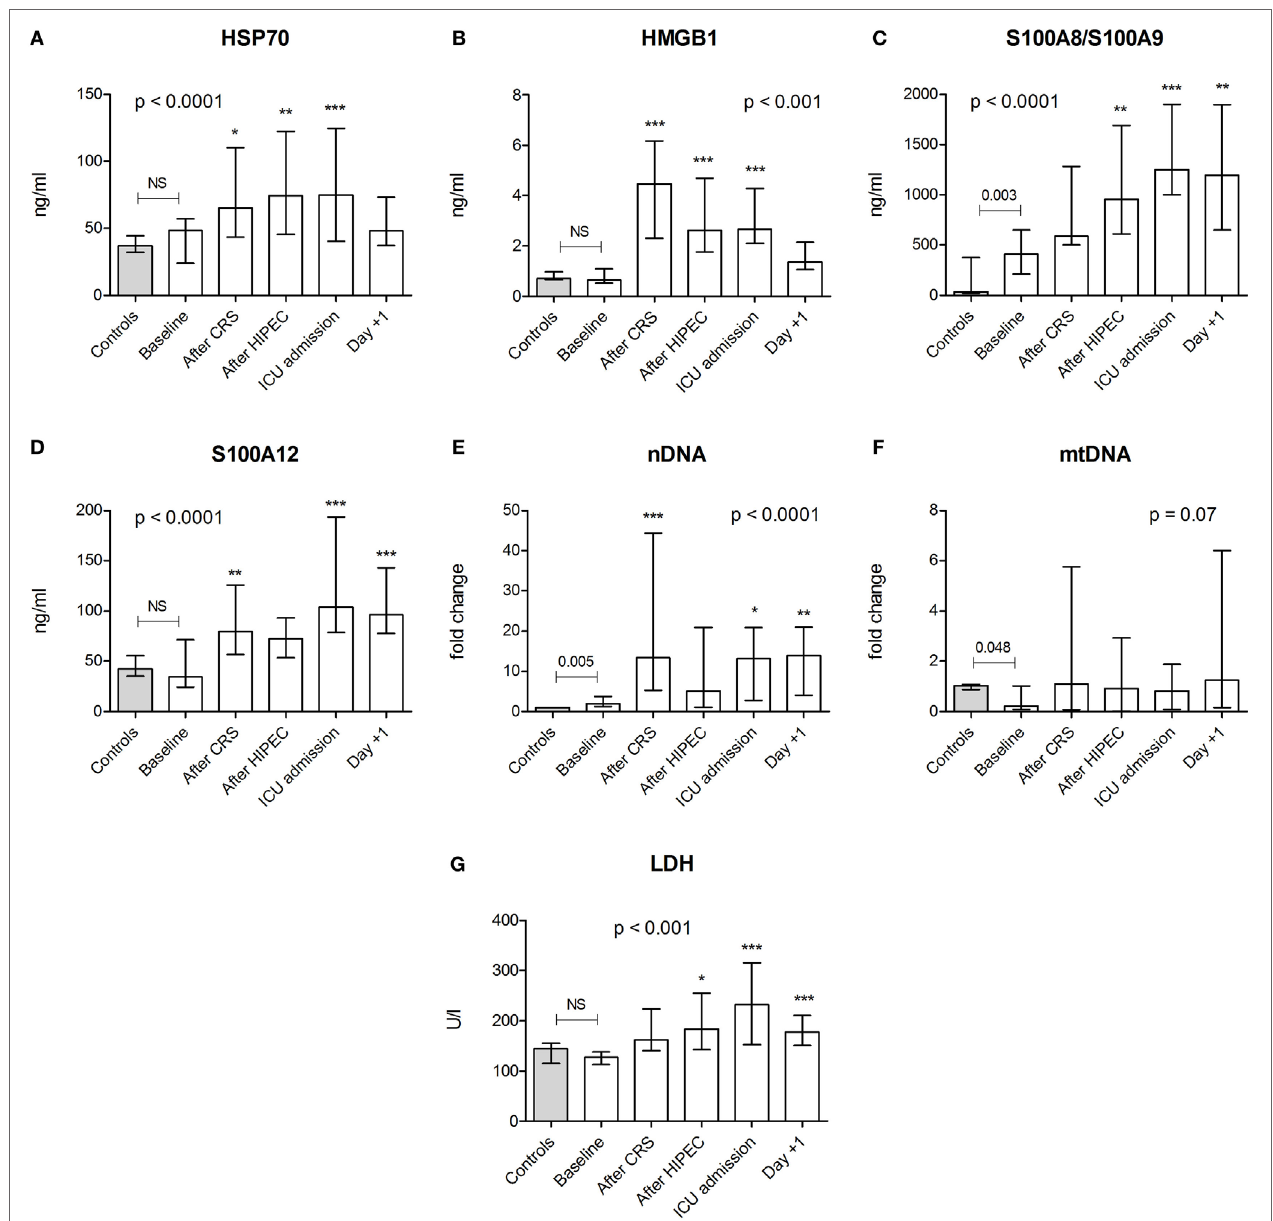
FigUre 1 | Plasma concentrations of danger-associated molecular patterns and lactate dehydrogenase (LDH). Plasma levels of (a) heat shock protein (HSP)70, (b) high mobility group box (HMGB)1, (c) S100A8/S100A9, (D) S100A12, (e) nuclear (n)DNA, (F) mitochondrial (mt)DNA, and (g) LDH in healthy controls ( n = 30 for HSP70, S100A8/S100A9, and S100A12; n = 12 for HMGB1, LDH, nDNA, and mtDNA) and in patients ( n = 20) at baseline and at various time points during and after the CRS-HIPEC procedure. nDNA and mtDNA levels are depicted as fold change compared to mean levels found in healthy controls. Data are presented as median + interquartile range. p- values indicating differences between controls and baseline patient data were calculated using Mann–Whitney U -tests. The p- values in each panel indicate differences within patient data over time and were calculated using Friedman tests with Dunn’s post hoc tests (* p < 0.05; ** p < 0.01; *** p < 0.001 compared with baseline). Abbreviations: NS, not significant; CRS, cytoreductive surgery; HIPEC, hyperthermic intraperitoneal chemotherapy; ICU, intensive care unit; Day + 1, first postoperative